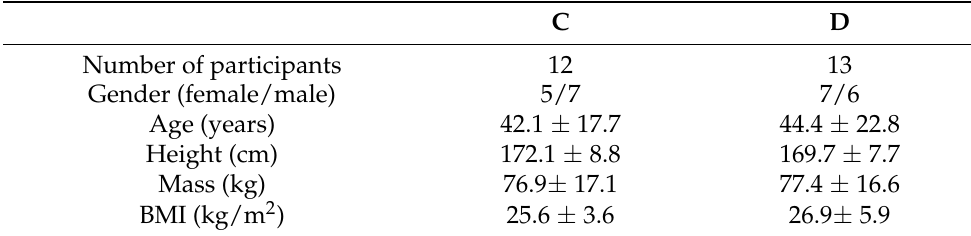
Table 1. Demographics of participants in this study. Control group participants (C) are those with no diagnosis of diabetes, participants with diabetes (D) only include those with no peripheral neuropathy. Values are mean ± standard deviation. Body mass index